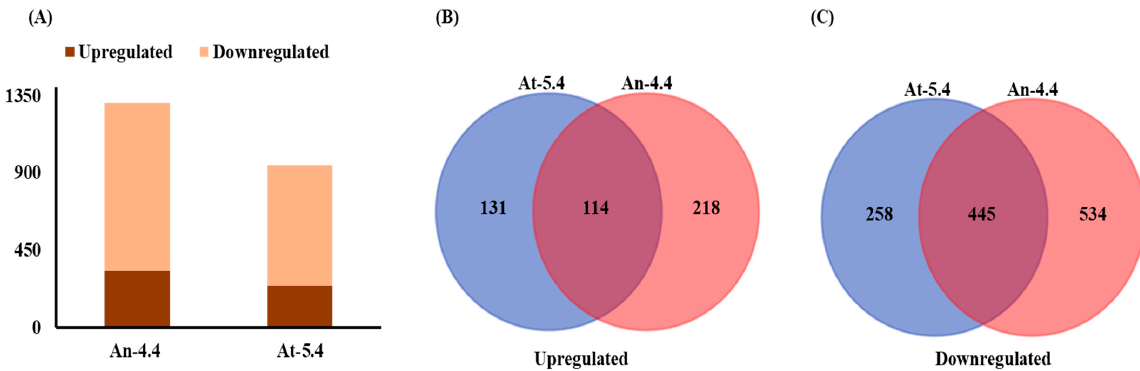
Figure 2. Microarray analysis of transgenic plants. ( A ) Number of significantly up and down regulated genes in An-4.4 and At-5.4; number of commonly up- ( B ) and downregulated ( C ) genes between An-4.4 and At-5.4.